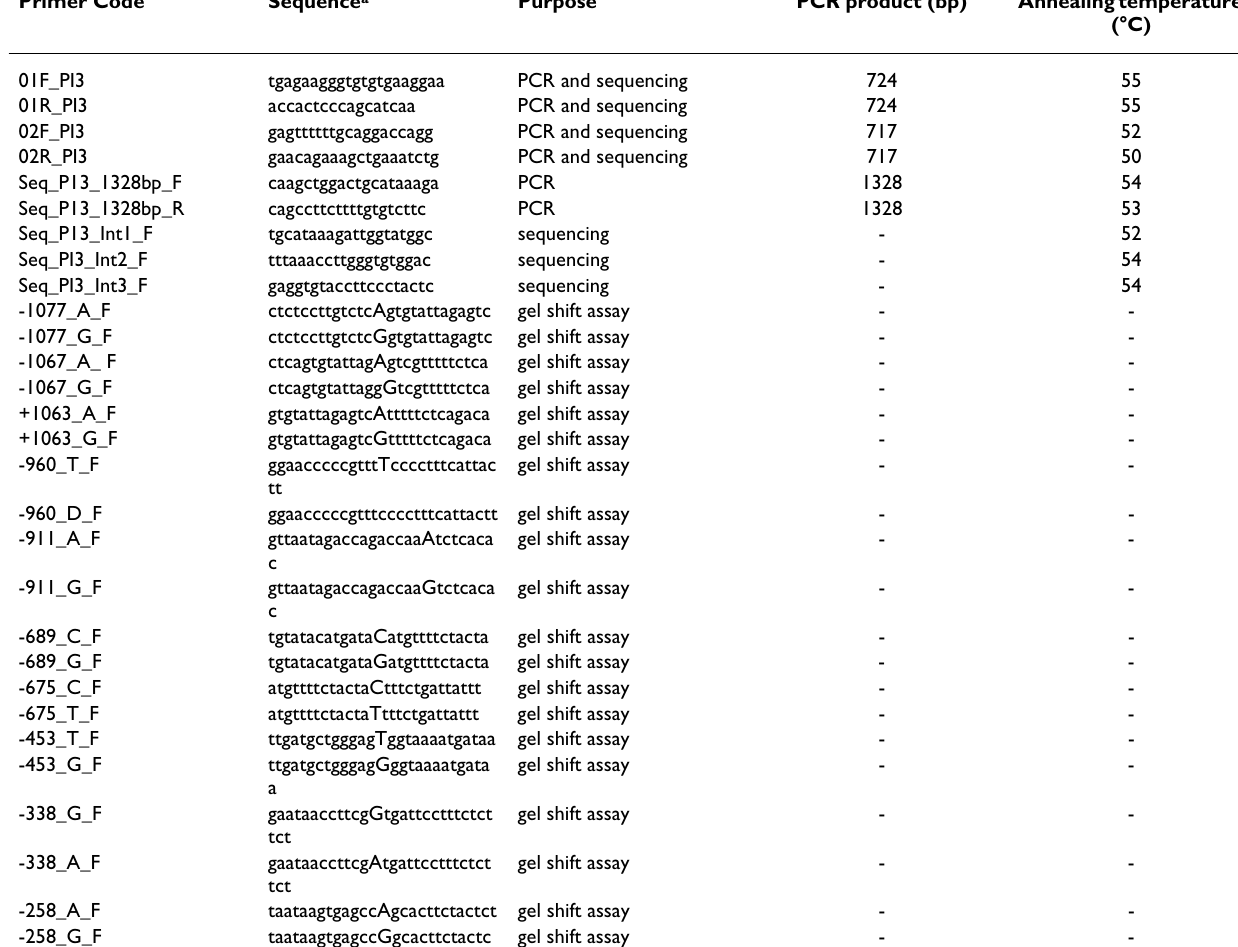
Table 1: Oligonucleotide primers used in the study. Primer